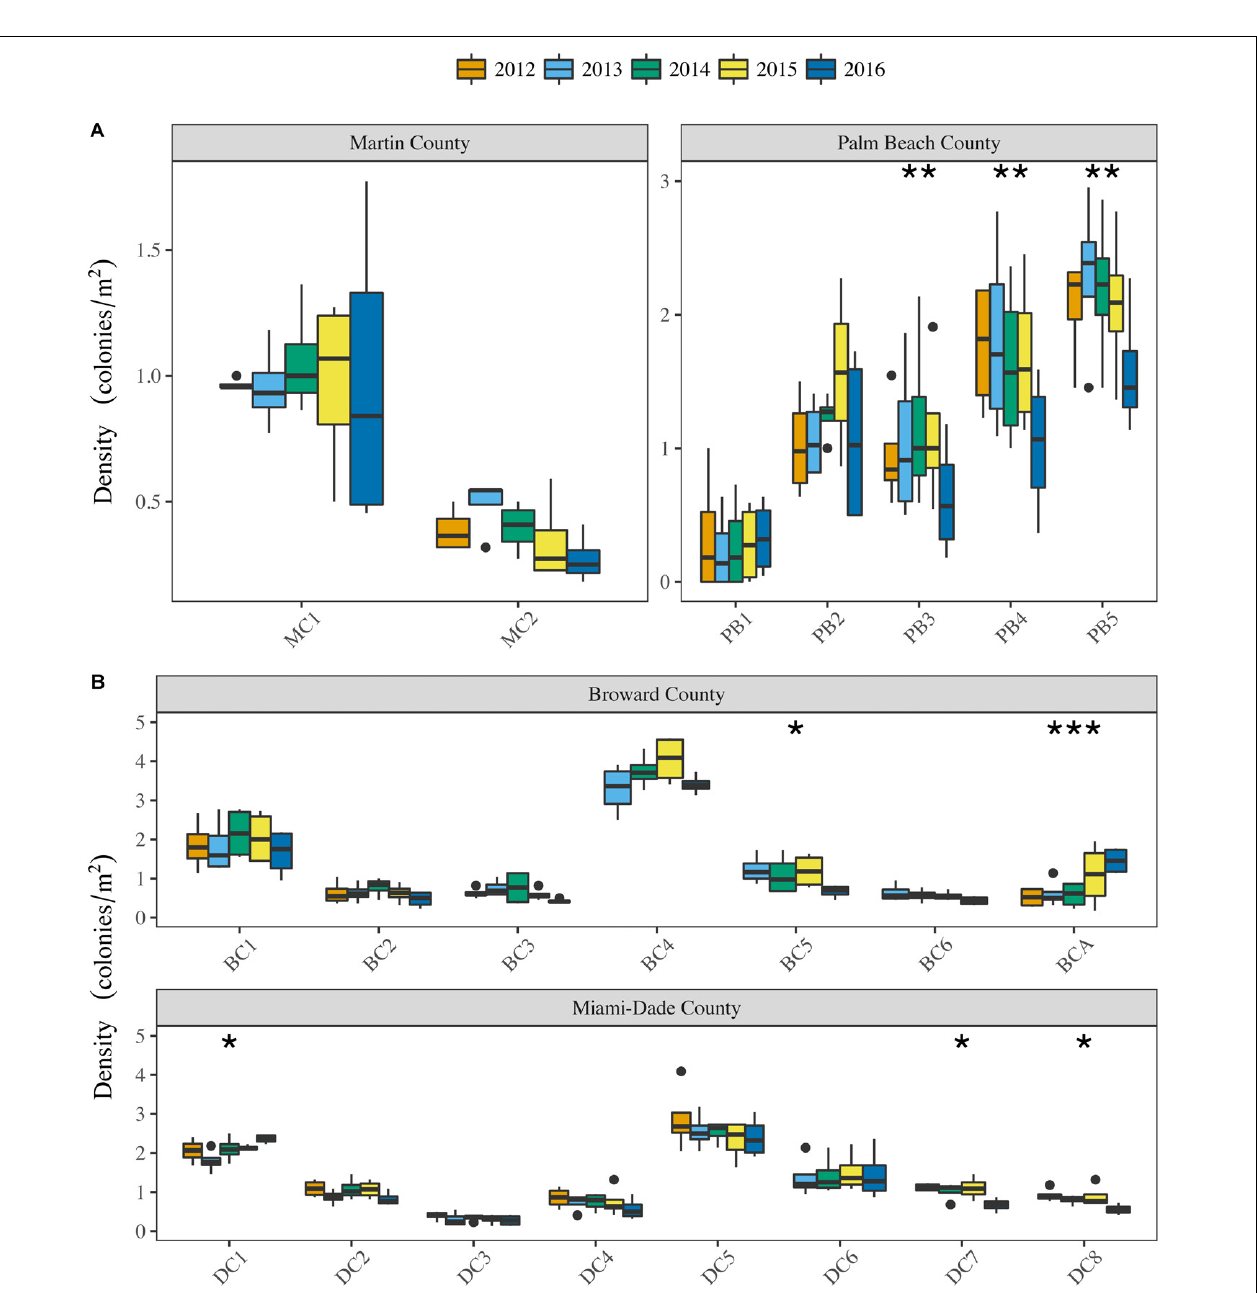
FIGURE 6 | Annual colony density per site in (A) Martin, Palm Beach, (B) Broward, and Miami-Dade counties. The middle bars of the boxplots represent the median values, the box length represents the interquartile range (IQR), the whiskers extend from the upper and lower IQR to the maximum and minimum values, and the dots indicate possible outliers. Asterisks indicate sites with significant differences between years. Post hoc tests for sites with significant differences showed: 2016 density was significantly less than all other years for PB3, PB4, PB5, BC5, DC7, and DC8; BCA density in 2016 was significantly greater than 2012-2014 and 2015 was significantly greater than 2012 and 2014; DC1 density in 2016 was significantly greater than 2013. ∗ p < 0.05; ∗∗ p < 0.01; ∗∗∗ p <